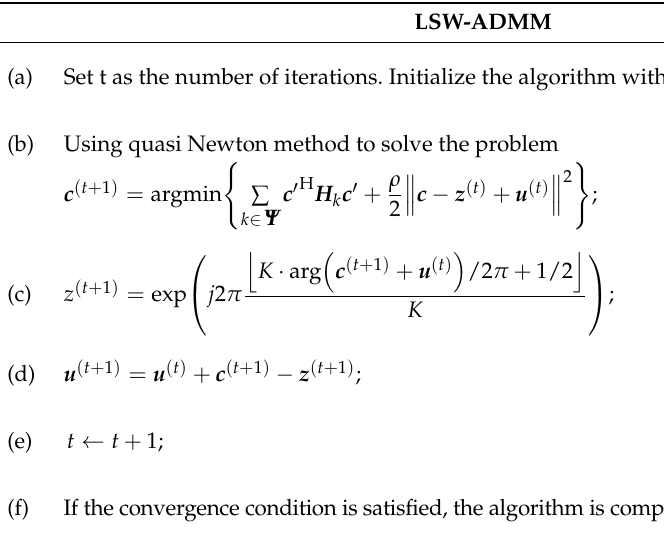
Table 1. LSW-ADMM steps.